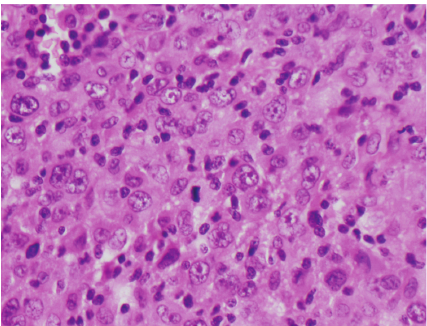
Figure 4: Pleomorphic epitheloid cells having vesicular nuclei and prominent nucleoli. A mitosis is present at the